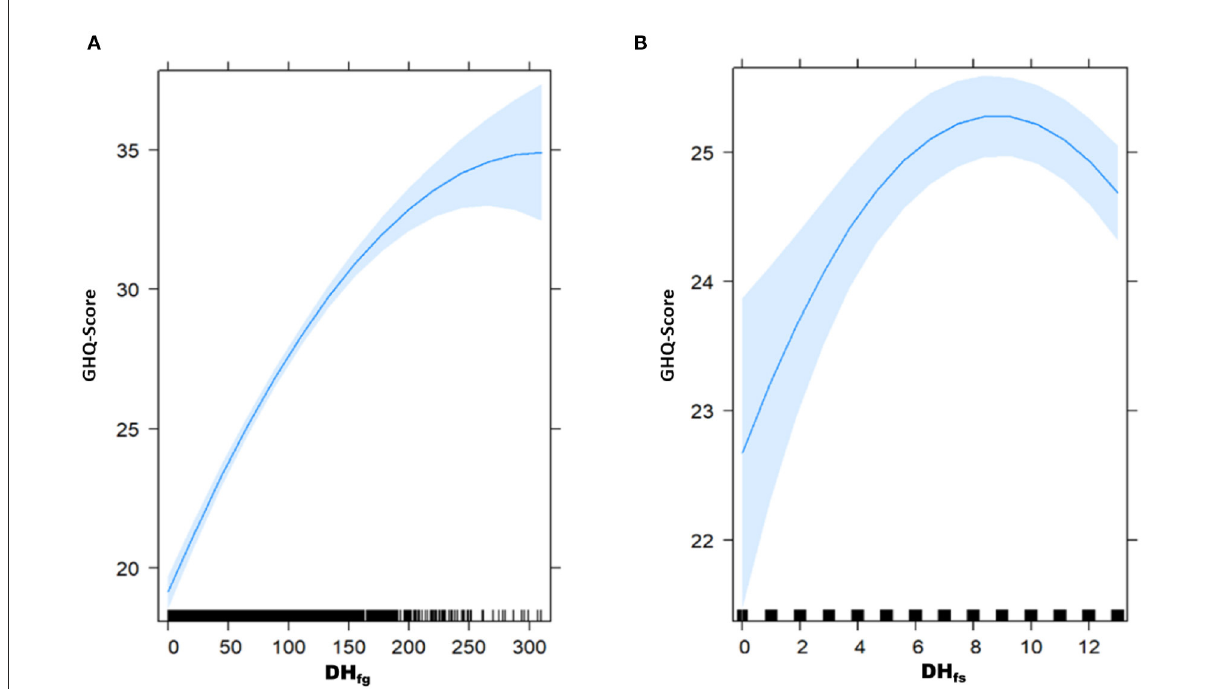
FIGURE4 Predicted stressor-health relationship [multivariate regression analyses with GHQ score as criterion and DH fg (A) or DH fs (B) as predictors,